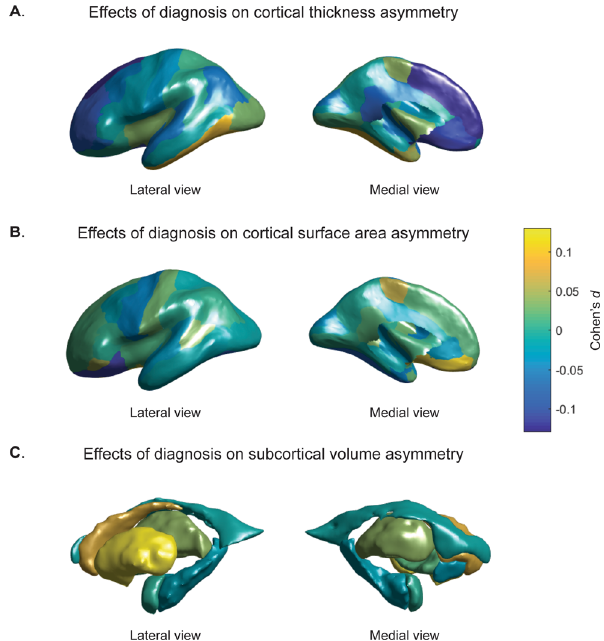
Fig. 1 Cohen ’ s d effect sizes of the associations between diagnosis and AIs. a regional cortical thickness measures, b cortical surface areas, c subcortical volumes. Values are overlaid on left hemisphere in fl ated brains. Positive Cohen ’ s d values (yellow) indicate mean shifts towards greater leftward or reduced rightward asymmetry in cases, and negative Cohen ’ s d values (blue) indicate mean shifts towards greater rightward asymmetry or reduced leftward asymmetry in individuals with